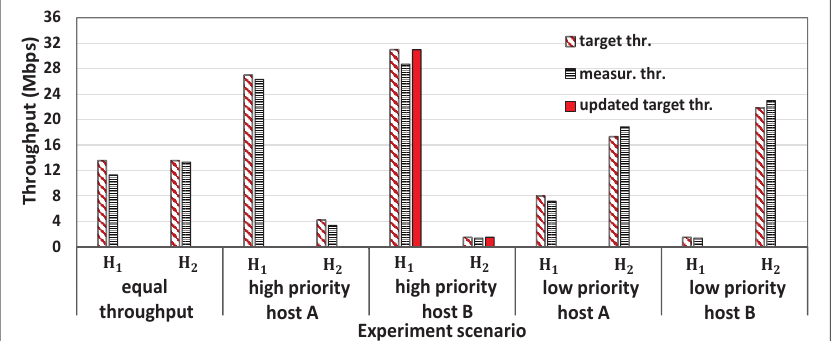
Figure 5. Measurement results of single and concurrent throughputs.